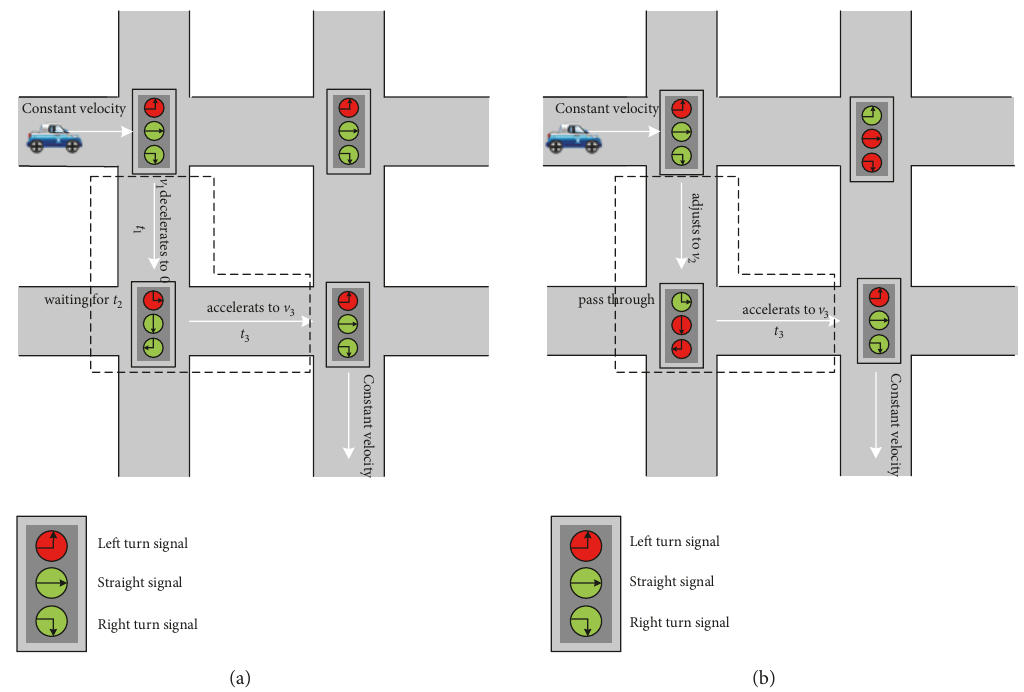
Figure 1: The driving process of the same trajectory under general circumstance and our proposed approach.